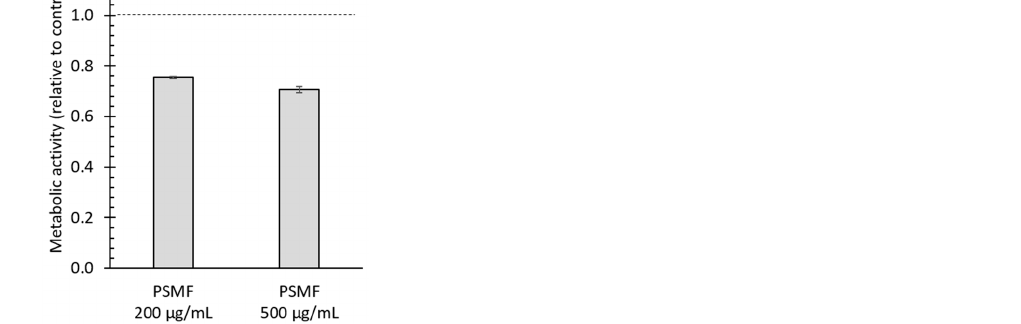
Figure A2. Cytotoxicity effects of PSMF. Metabolic activity (relative to control), measured with the 3-(4,5-dimethylthiazol-2-yl)-2,5-diphenyltetrazolium bromide) tetrazolium reduction (MTT) assay, of the Caco-2 monolayer after exposure to 0, 200, and 500 µg/mL PSMF ( n = 4).